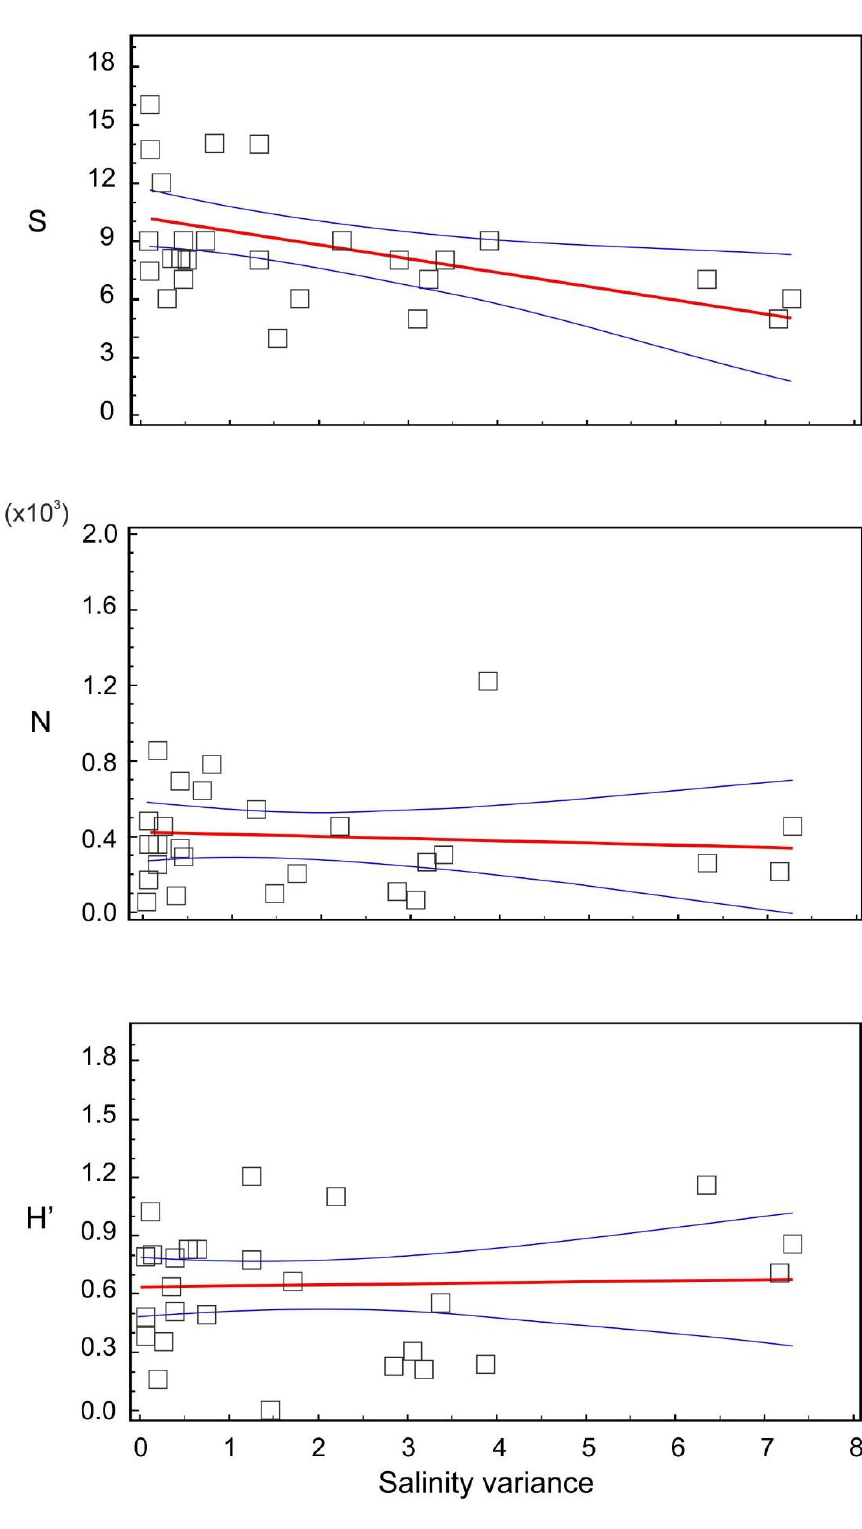
Figure 5. Mean diversity (H’), mean number of species (S) and mean abundance (N) versus salinity variance over the sampling occasions, blue lines indicate 95% confidence interval.